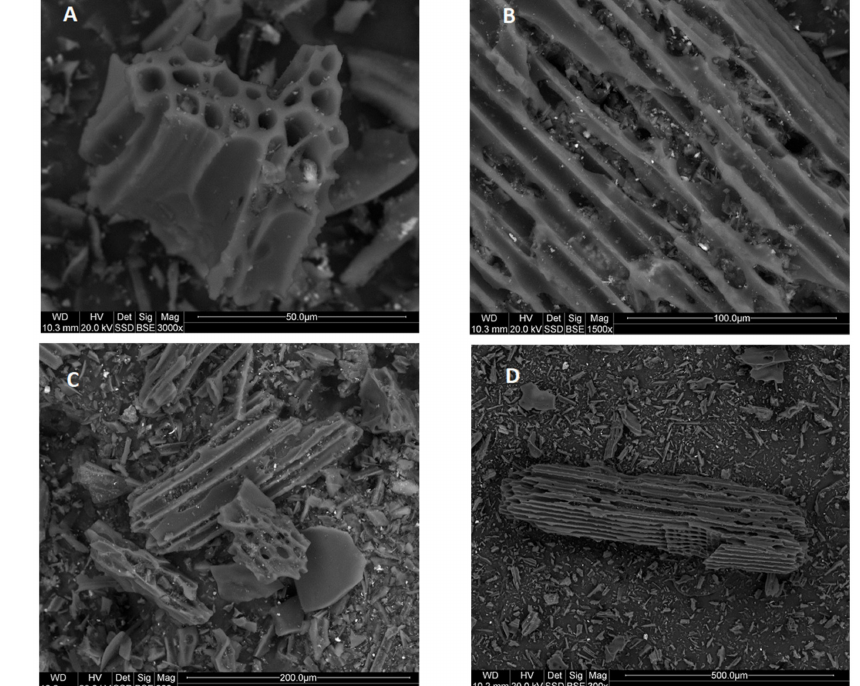
Figure 3. ( A – D ) The SEM of dry residue cavitated charcoal.